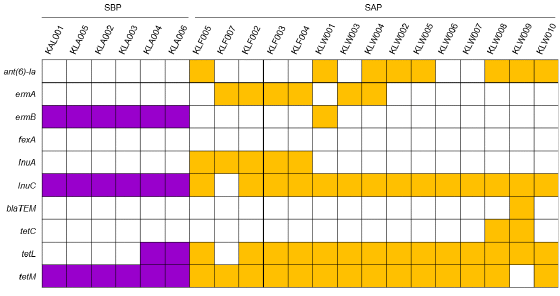
Fig 2. Comparison of AR genes of the isolated strains. Nucleotidesequencesof AR geneswere obtained from CARD. Orthologs of L . salivarius strains were alignedto the databaseusing BLAST+, and orthologs showingE-value = 0 and identity (cid:21) 90% were regardedas AR genes (coloredsquare).